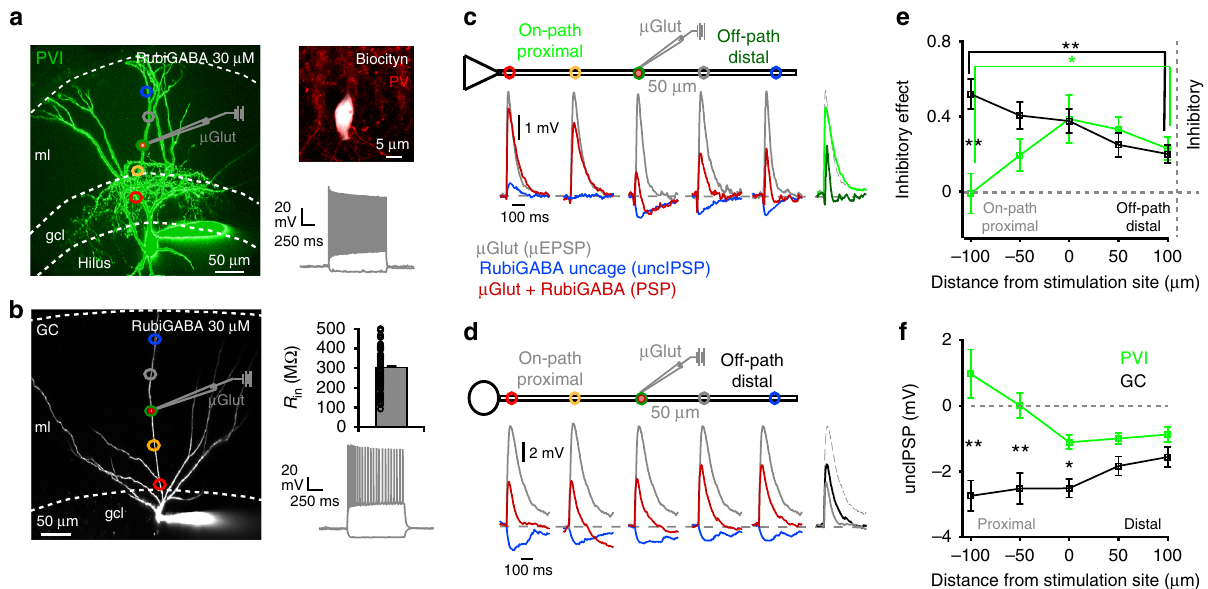
Fig. 1 Different ef fi ciency of on- and off-path inhibition in PVIs and GCs. a , b Left, two-photon image stack of a PVI ( a ) and a GC ( b ) loaded with Alexa Fluor-488. Somatic whole-cell recordings were performed while RubiGABA was uncaged at one out of fi ve locations (colored circles) relative to the glutamate microiontophoresis ( µ Glut) stimulation site (scale bar 50 µ m). Right upper, PV antibody-labeling of the cell shown on the left and its fast-spiking phenotype ( − 100 and 800 pA, 1 s, 233.6 Hz). Right lower, bar graph summarizing input resistances ( R in ) for 94 recorded GCs. Circles represent individual data points. Bottom, fi ring pattern of the GC shown on the left ( − 50 and 400pA, 1 s, 30.9 Hz). c , d Schematic of a PVI and GC cell body (triangle and circle, respectively) with one apical dendrite. EPSPs were evoked by glutamate microiontophoresis ( µ EPSPs) at the middle apical dendrite of PVIs and GCs (154.5 ± 7.3 and 143.1 ± 8.7 µ m distance from the soma, respectively; six PVIs, ten GCs, represented by µ Glut pipette). GABA was uncaged at fi ve locations (uncIPSP) relative to the µ Glut position (50 µ m steps). Superimposed traces show corresponding control µ EPSPS (gray), IPSPs evoked by RubiGABA uncaging (uncIPSPs, blue) and PSPs resulting from the interaction of µ EPSPs and uncIPSPs at the corresponding fi ve uncaging locations (red). Superimposed traces on the right show µ EPSP (gray dashed) and PSPs resulting from µ EPSPs and uncIPSPs interaction at on-path ( − 100 µ m; PVI bright- green, GC gray trace) and off-path ( + 100 µ m; PVI dark green, GC black trace) uncaging locations. e Inhibitory effect calculated as 1 − (PSP amplitude/ µ EPSP amplitude) is plotted against uncaging location. Note on-path inhibition has a signi fi cantly larger effect on µ EPSPs in GCs compared to PVIs (black vs. green lines, respectively), and off-path is more ef fi cient than on-path inhibition in PVIs. f Mean uncIPSP amplitudes are plotted as a function of distance from µ Glut stimulation site in PVIs (green) and GCs (black). Squares and bars with lines represent mean ± s.e.m. * p ≤ 0.05; ** p ≤ 0.01. ml molecular layer, gcl granule cell